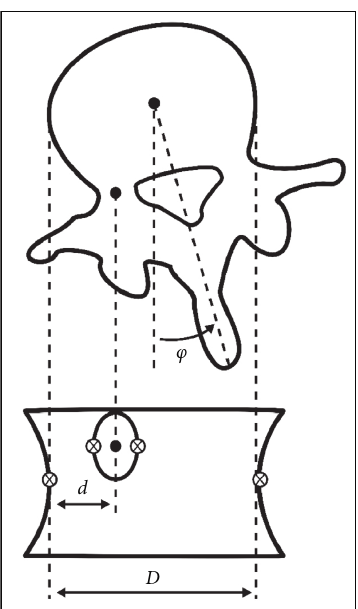
Figure 1: A schematic description of the anatomical references used to measure AVR in two-dimensional images.